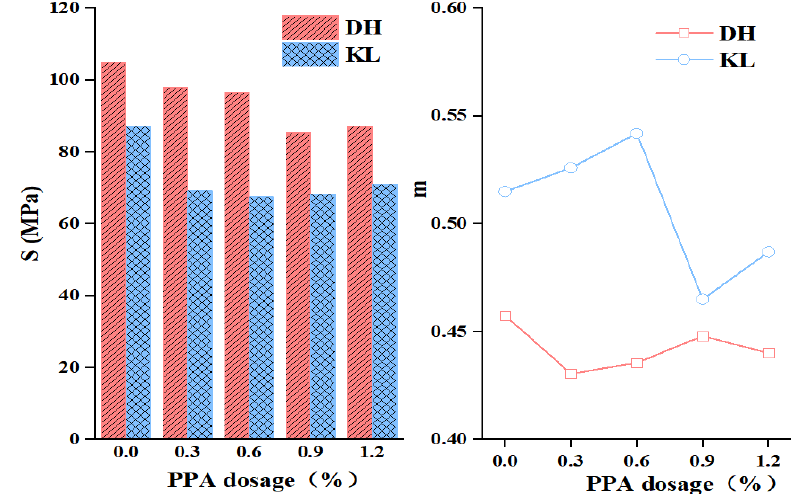
Figure 6. S and m of single modified asphalt with different PPA dosages.